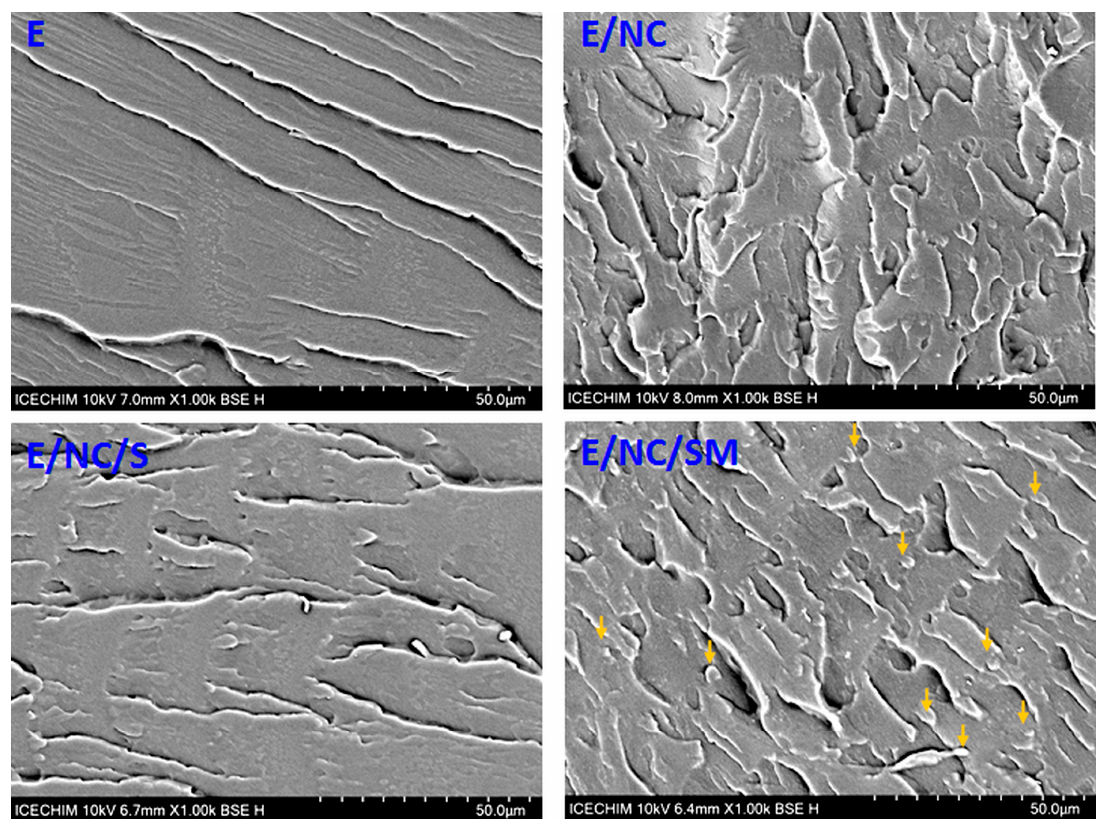
Figure 9. SEM micrographs of cryo-fractured surfaces of cured neat epoxy matrix and epoxy/NCs nanocomposites (×1000).